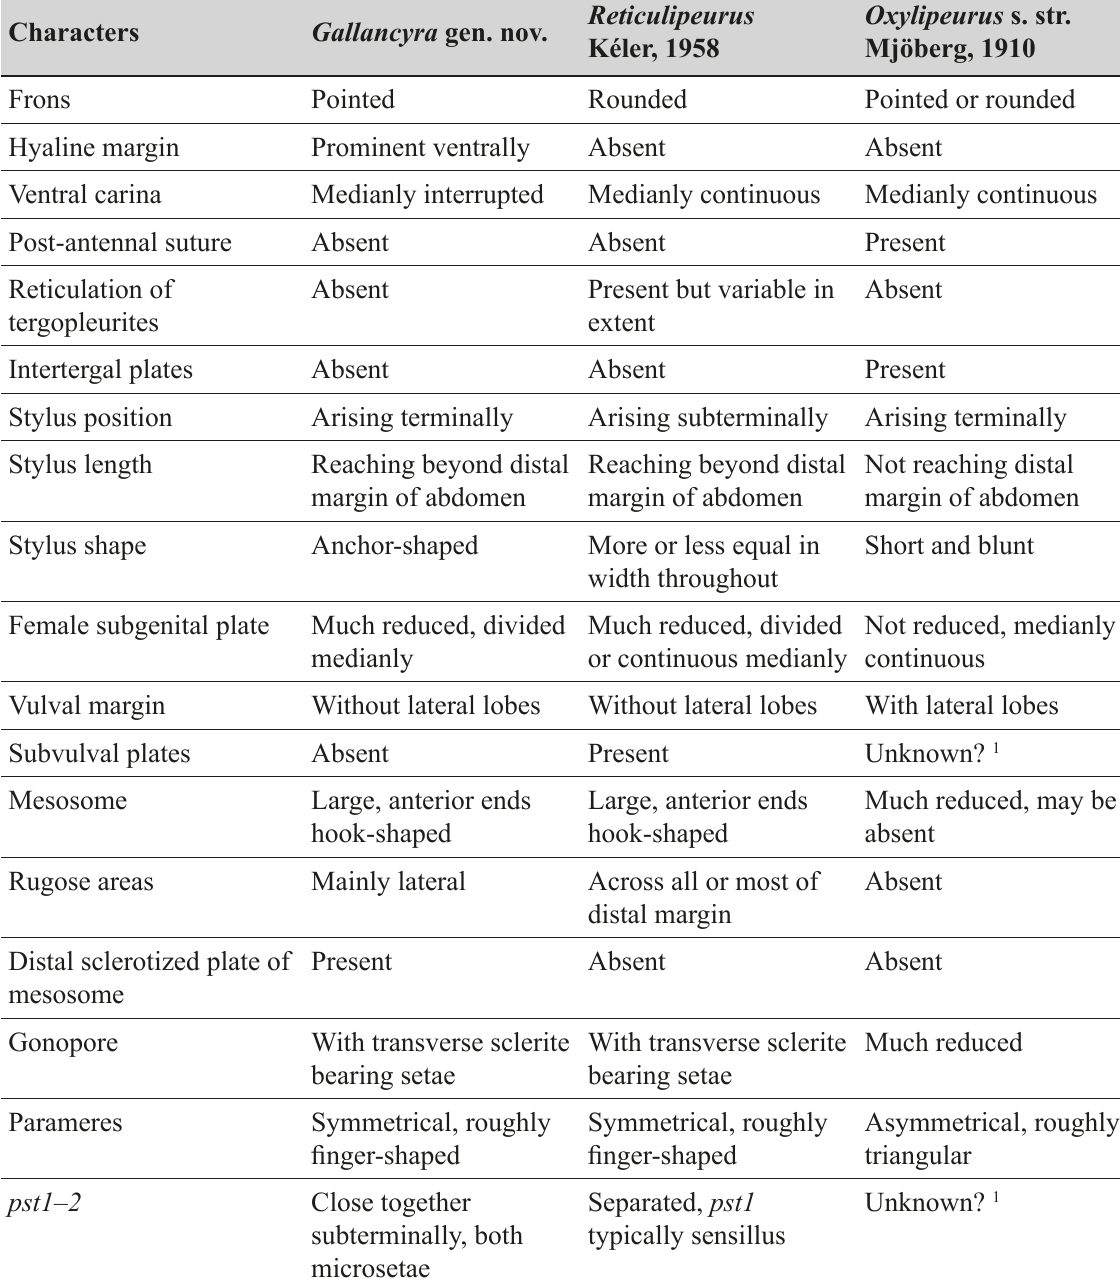
Table 3. Morphological comparison of Gallancyra gen. nov., Reticulipeurus Kéler, 1958 and Oxylipeurus Mjöberg, 1910. Note that genitalia of Oxylipeurus s. str. are hard to homologize with those of other genera in the complex based on published illustrations (e.g., Mey 1990). In particular, the mesosome of species in this genus appears to be much reduced and fused to the basal